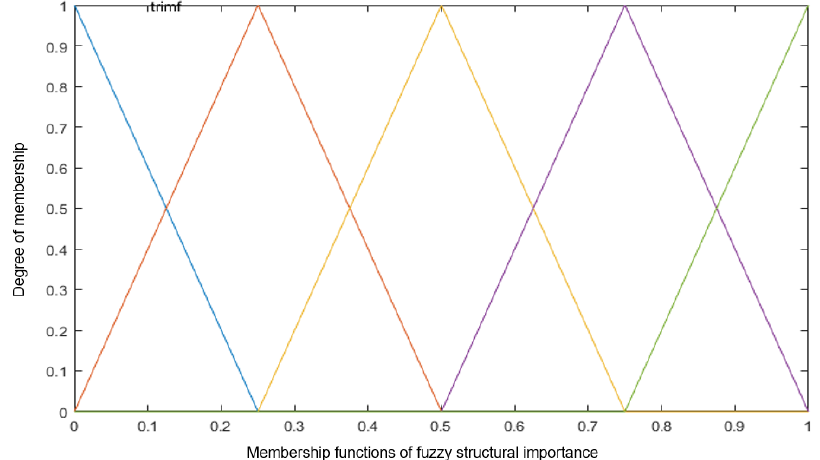
Figure 3. Membership functions of fuzzy sets of elements structural importance.